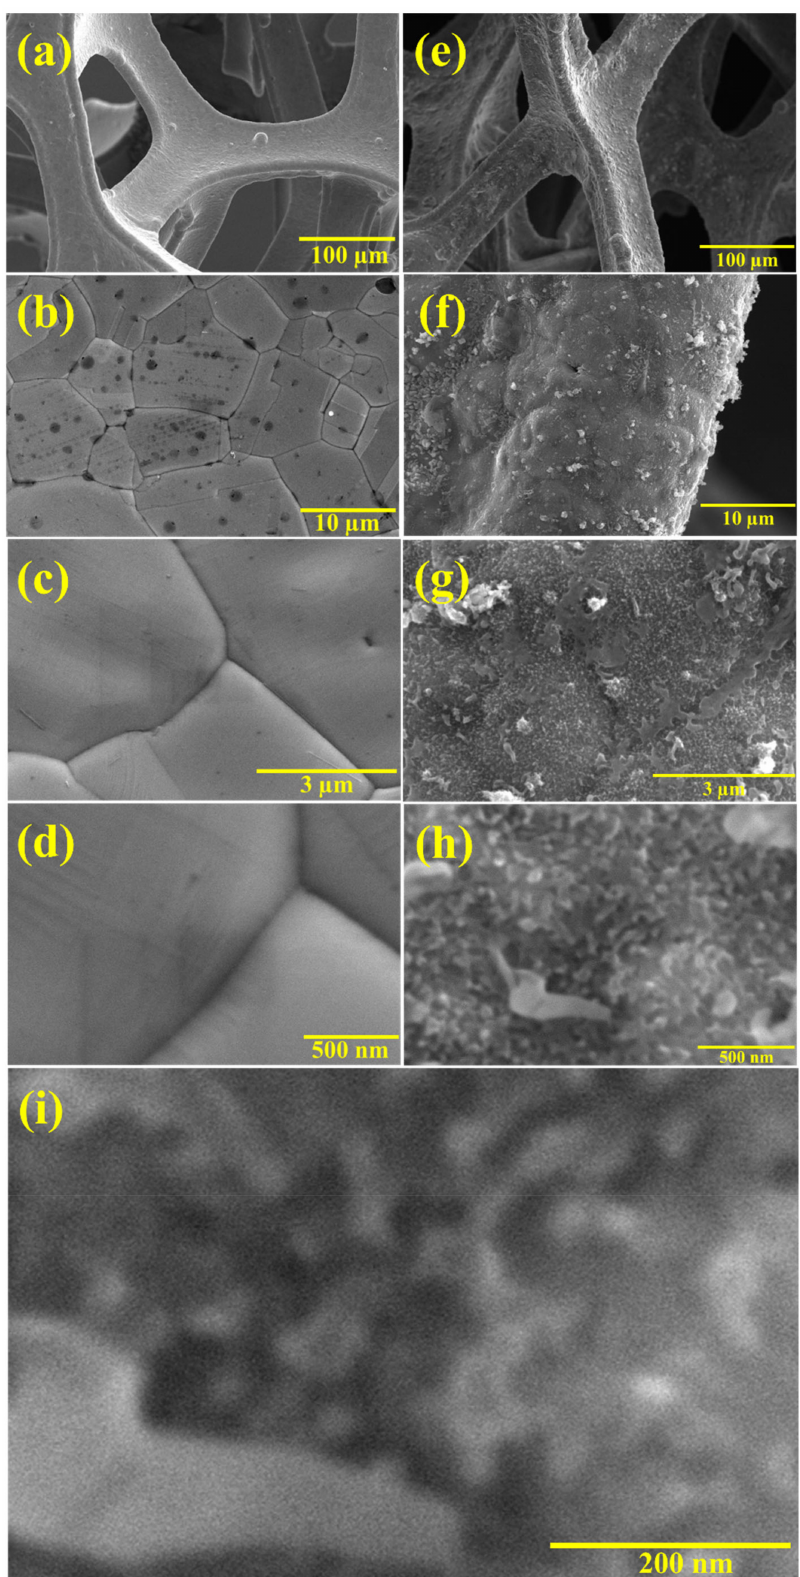
Figure 2. FESEM micrographs of ( a – d ) bare NF and ( e – i ) PANI/NF at different